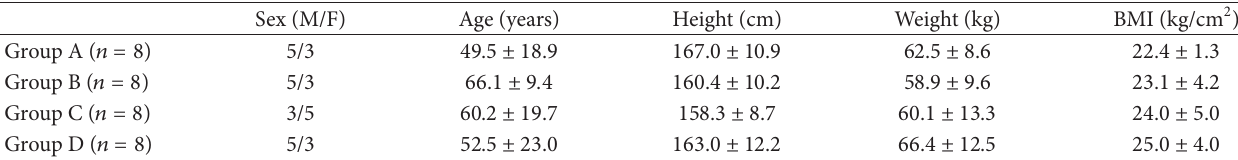
Figure 1: Patient flow through the study. Groups A and B received 1mg/kg and 0.5 mg/kg of sugammadex (Sug), respectively, as a first dose when the second twitch (T2) reappeared in train-of-four stimulation (TOF), and Groups C and D received 1mg/kg and 0.5 mg/kg of Sug, respectively, as the first dose at posttetanic counts 1–3 (PTC 1–3). Five minutes after the first dose, an additional 1mg/kg of Sug was administered and changes in first twitch height of TOF (T1 height) and train-of-four ratio (TOFR) were observed. Patients were divided into a recovered group and a partly recovered group, based on percentage changes in T1 height after additional dosing. T1 height and TOFR during the 5 min after first dose were then compared. Table 1: Patient